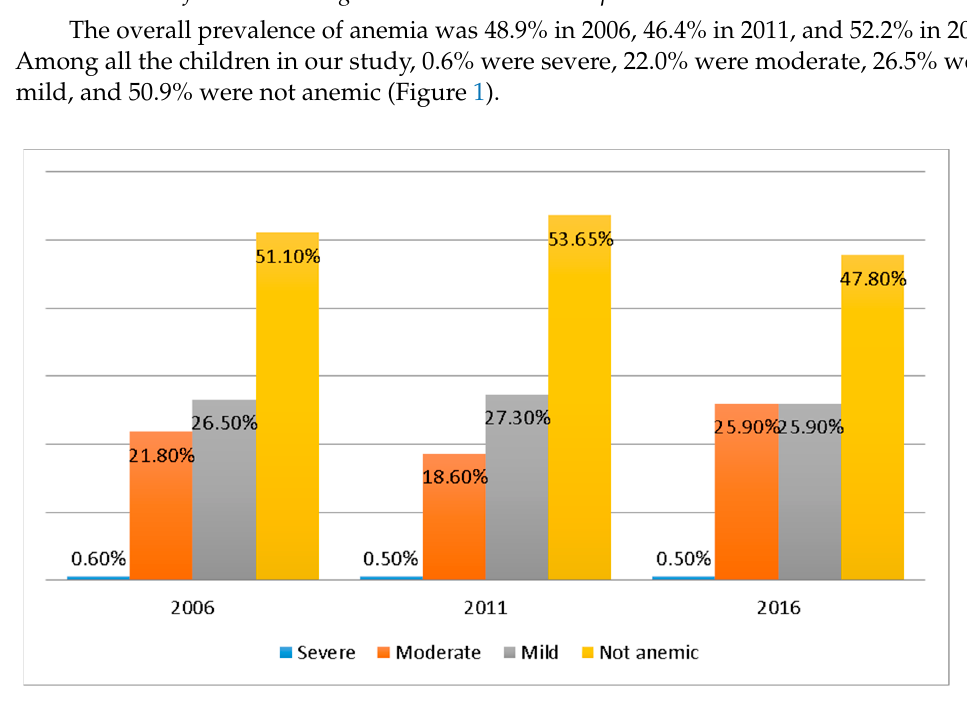
Figure 1. Prevalence of anemia among under-five children in Nepal (NDHS 2006–2016).